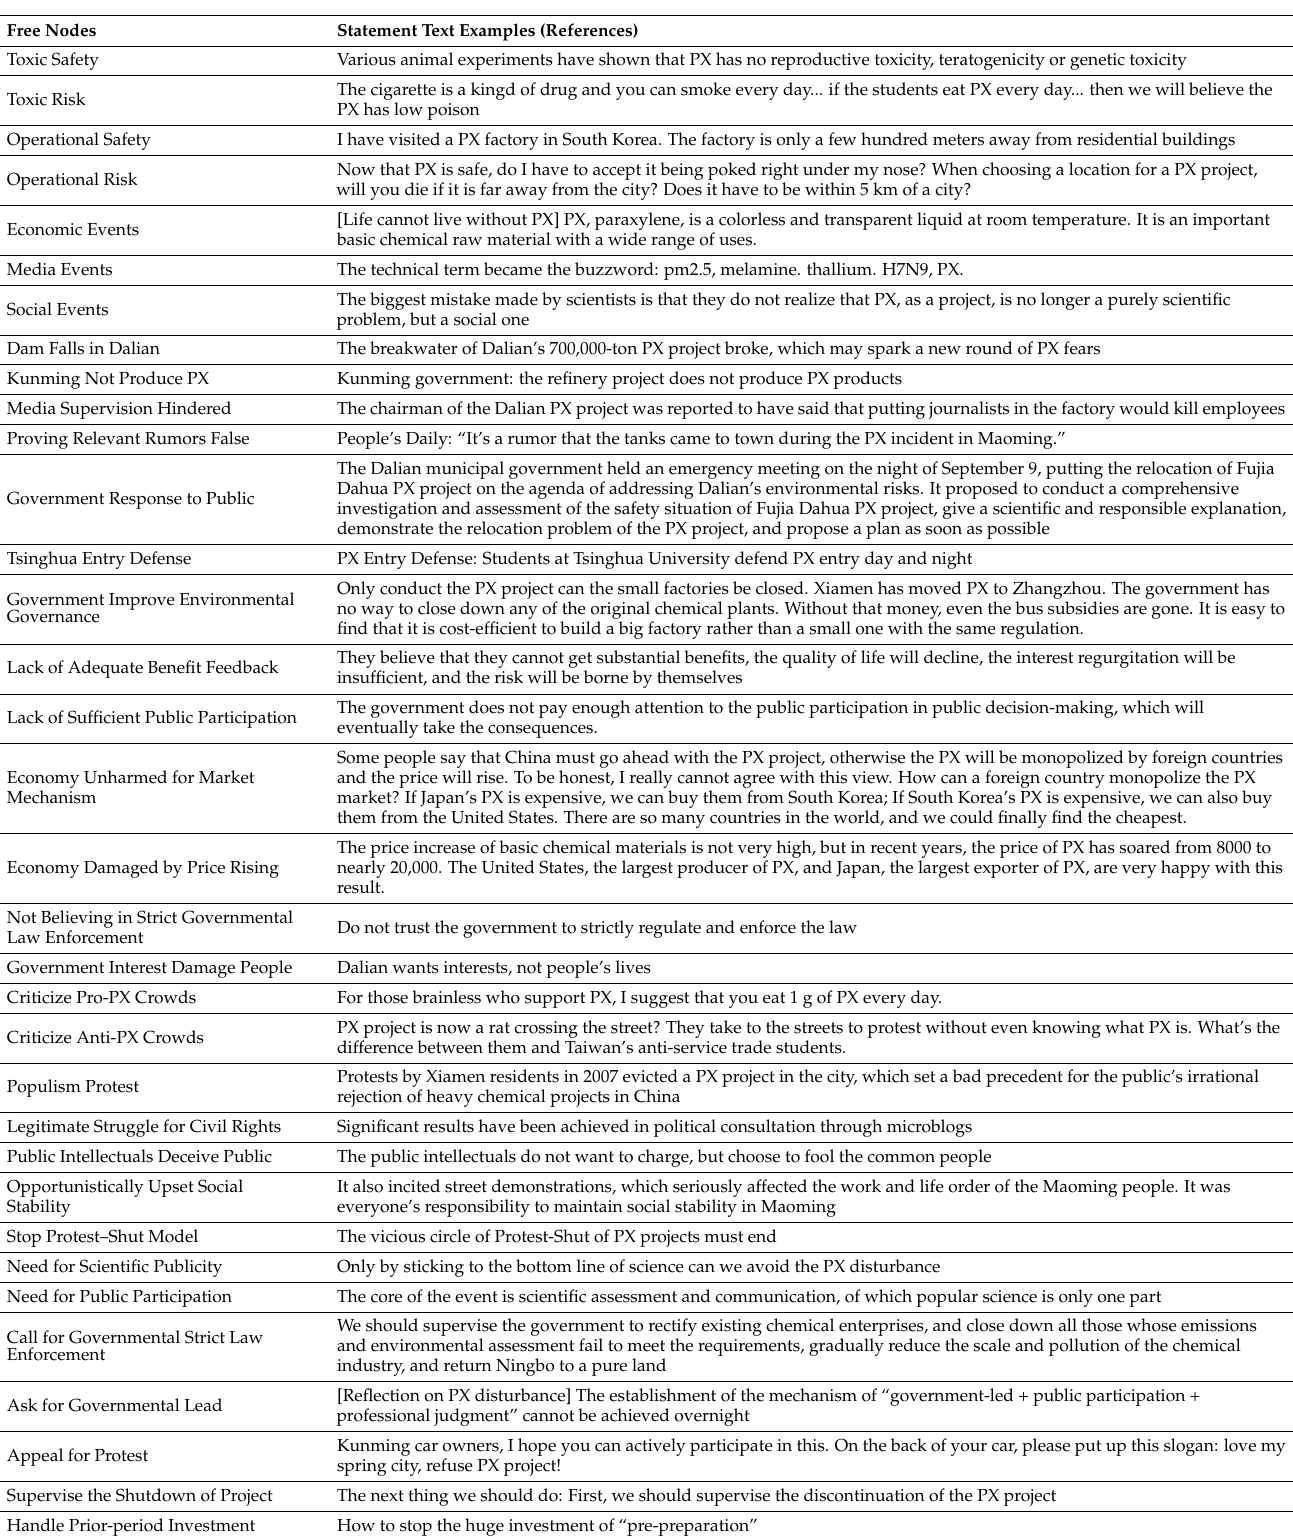
Table 2. Reference point examples of open